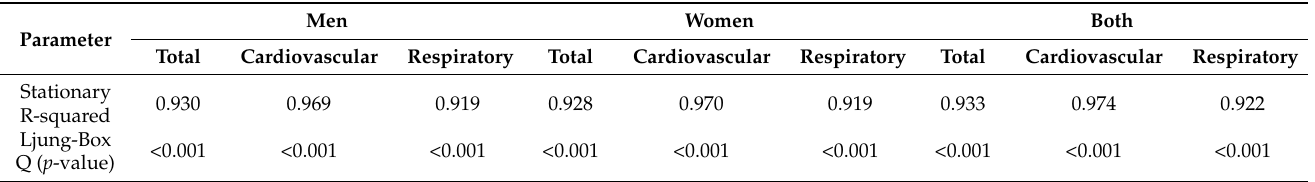
Figure 3. Time series for the number of hospital admissions per 100,000 female inhabitants in Spain: 1978–2018 data. The dotted line indicates when the copayment system was implemented. The top figure corresponds to all-cause admissions, the middle figure to cardiovascular admissions and the bottom figure to respiratory admissions. Table 2. Goodness of fit of the ARIMA (2,0,0)(1,0,0) models to assess the impact of copayment on the rate of emergency hospital admissions per 100,000 inhabitants in Spain: 1978–2018